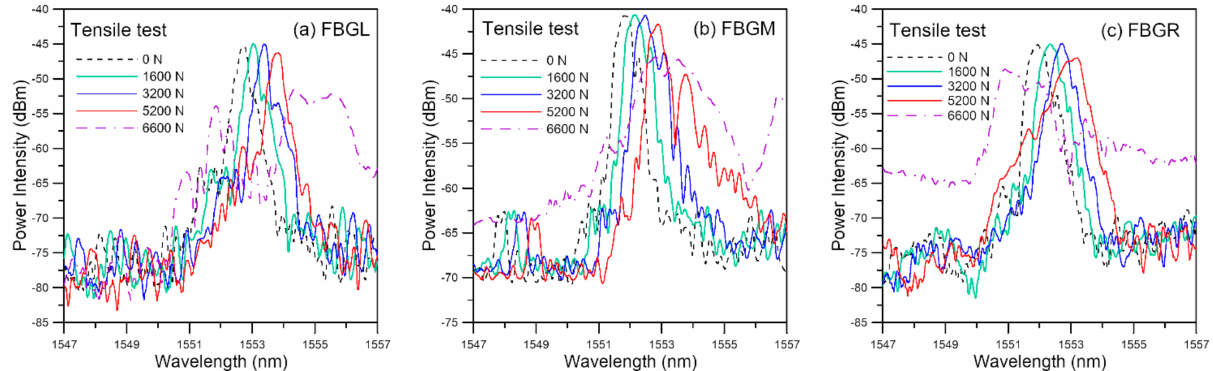
Figure 3. Evolution of FBG spectra measured at various loads as tensile loading